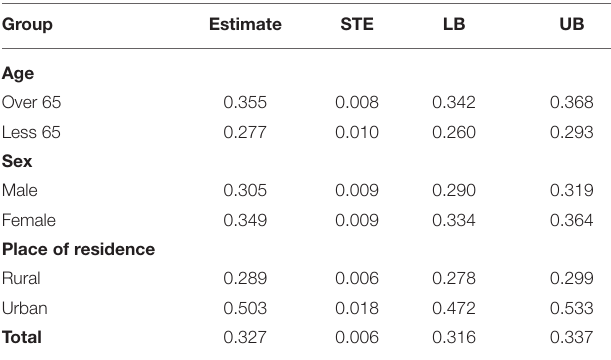
TABLE 9 | BC a indexes among older people by different age, gender, and place of residence. Group Estimate STE